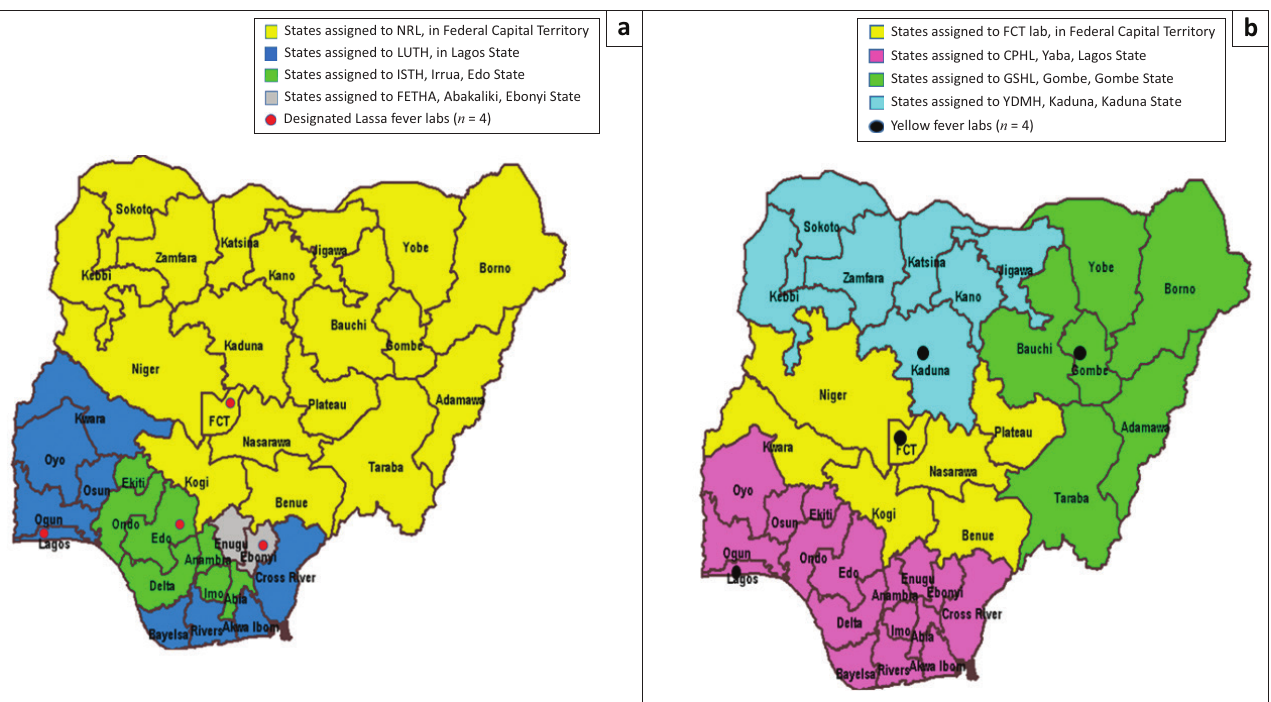
FIGURE 2: Geographic location and specimen referral catchment areas for the Lassa fever and yellow fever laboratories. (a) Lassa fever laboratories, (b) Yellow fever laboratories.